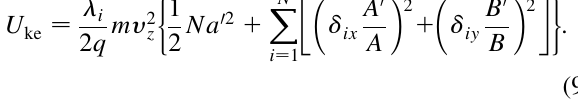
FIG. 12. Sample particle simulation showing the beamlet offset caused by aperture